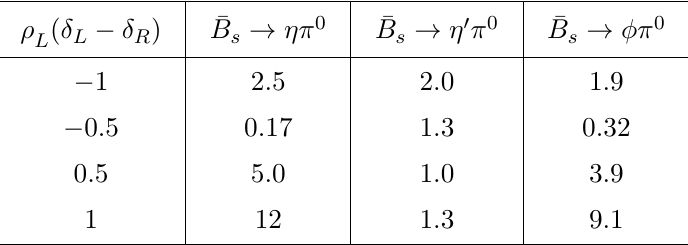
( (cid:14) L (cid:0) (cid:14) R ) in the case where (cid:26) L